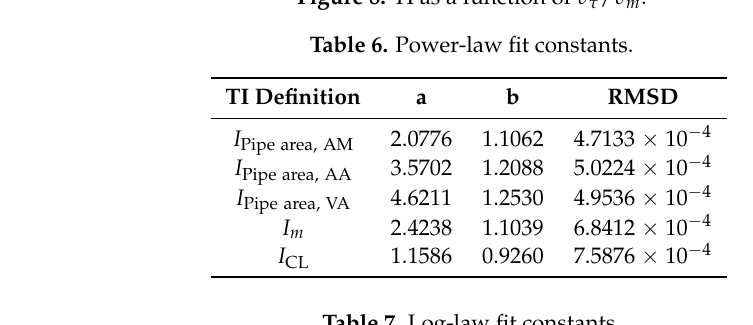
Table 7. Log-law fit